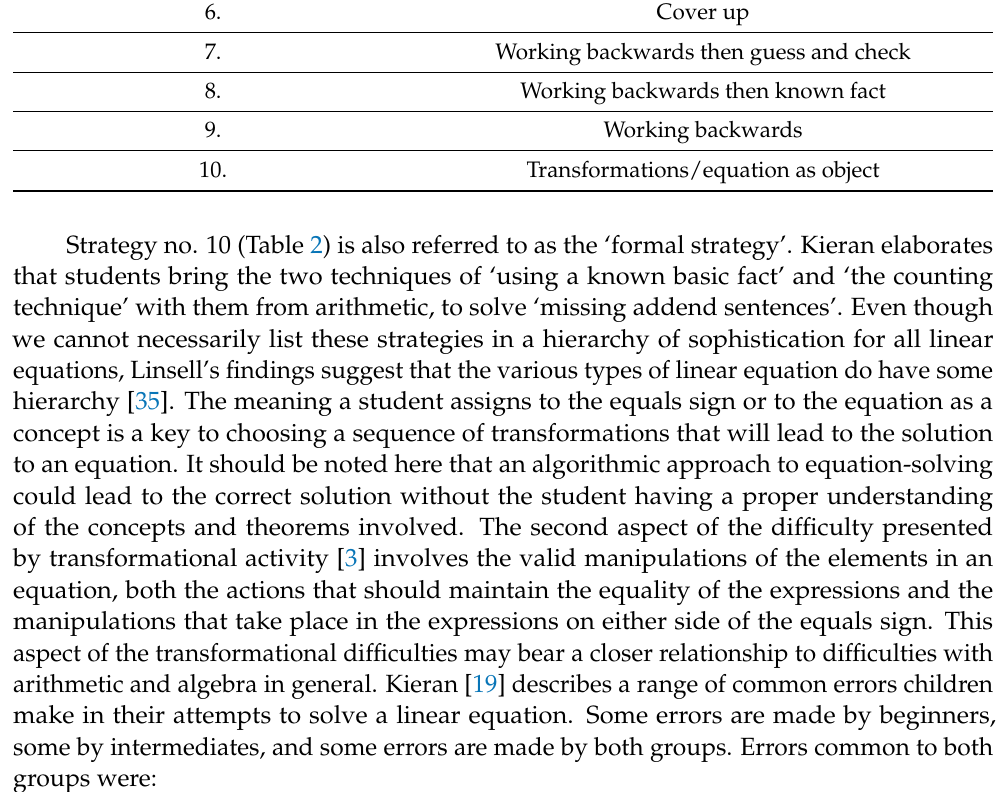
Table 2. Classification of strategies used for coding [35] (p. 333), drawing on [10]. 1. Unable to answer question 2. Known basic facts